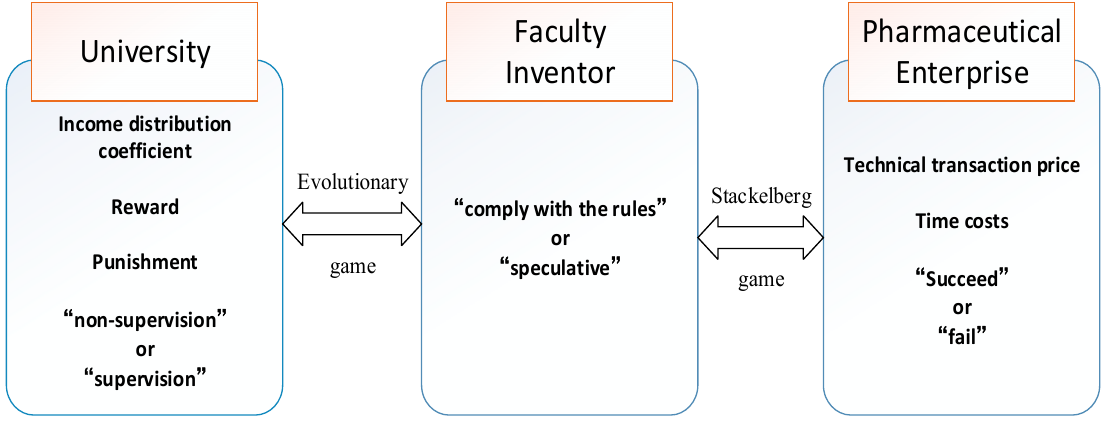
Figure 2. The specific process of the game among universities, faculty inventors, and pharmaceutical Companies.